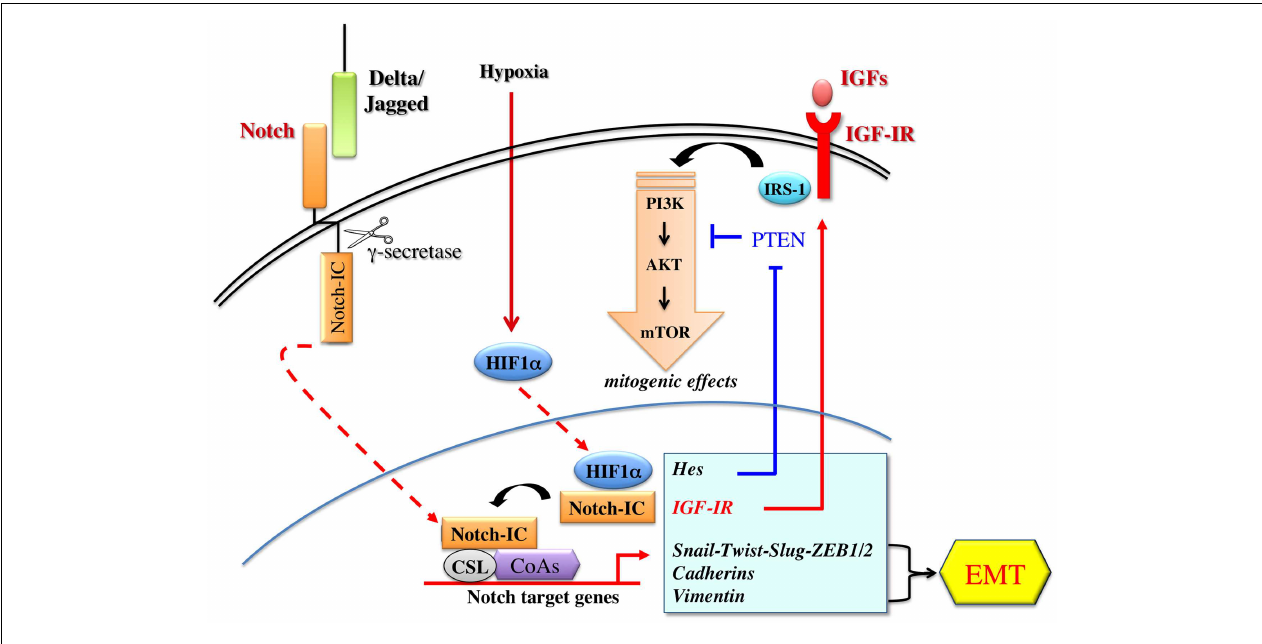
recruit co-activators (CoAs) to activate transcription. Notch dependent signaling induces several genes associated with differentiation, survival, stemness, and EMT. Notch target genes include Hes and Hey family of basic helix-loop-helix transcription factors, D-cyclins, transcription and growth factors relevant to EMT and to IGF-IR/PI3K pathway. Notch signaling is often and aberrantly activated by hypoxia through HIF-1- α . Under hypoxic conditions, Notch-1 stimulates IGF-IR transcription by regulating its promoter and amplifying the mitogenic effects mediated by IGF-IR/PI3K